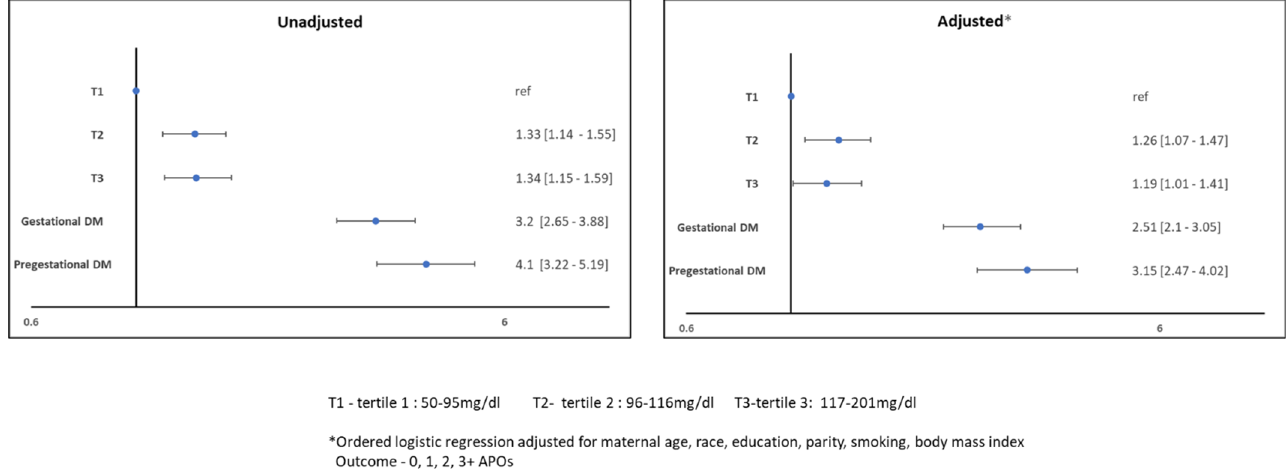
Figure 2. Association of Cumulative APOs with Maternal Glycemic